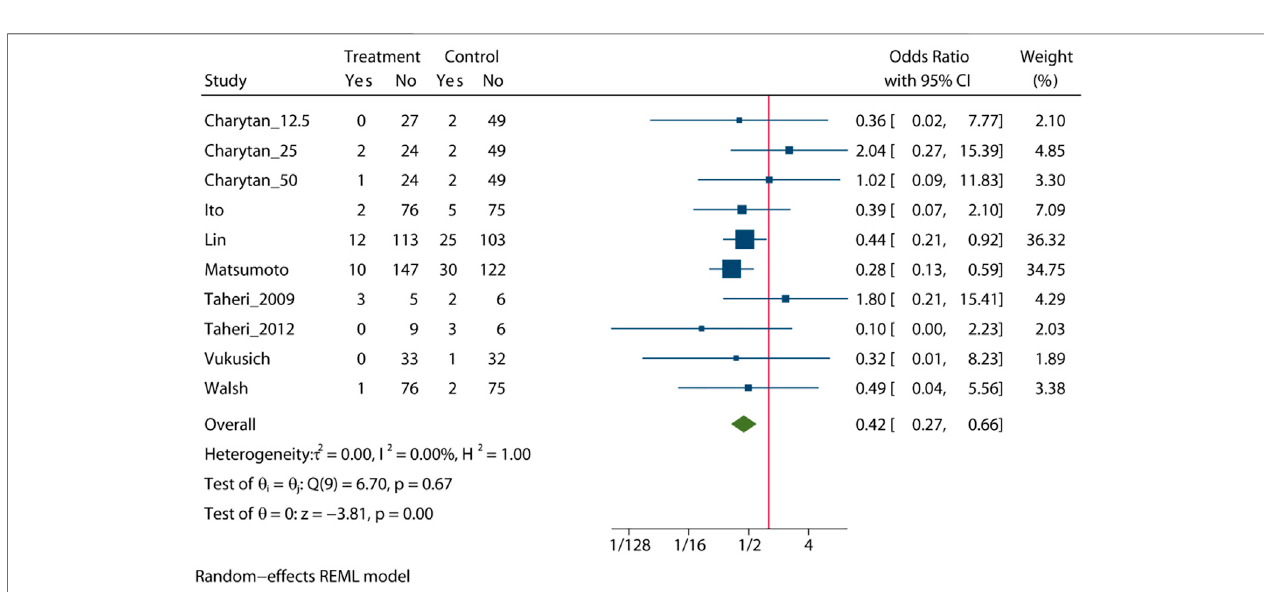
FIGURE 2 | All-cause mortality among patients with MRA vs. control.